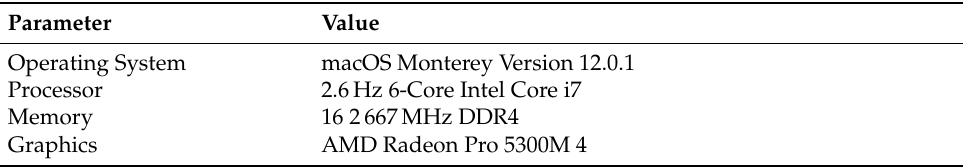
Table 7. Computer specification of the utilized MacBook Pro (16-inch, 2019).